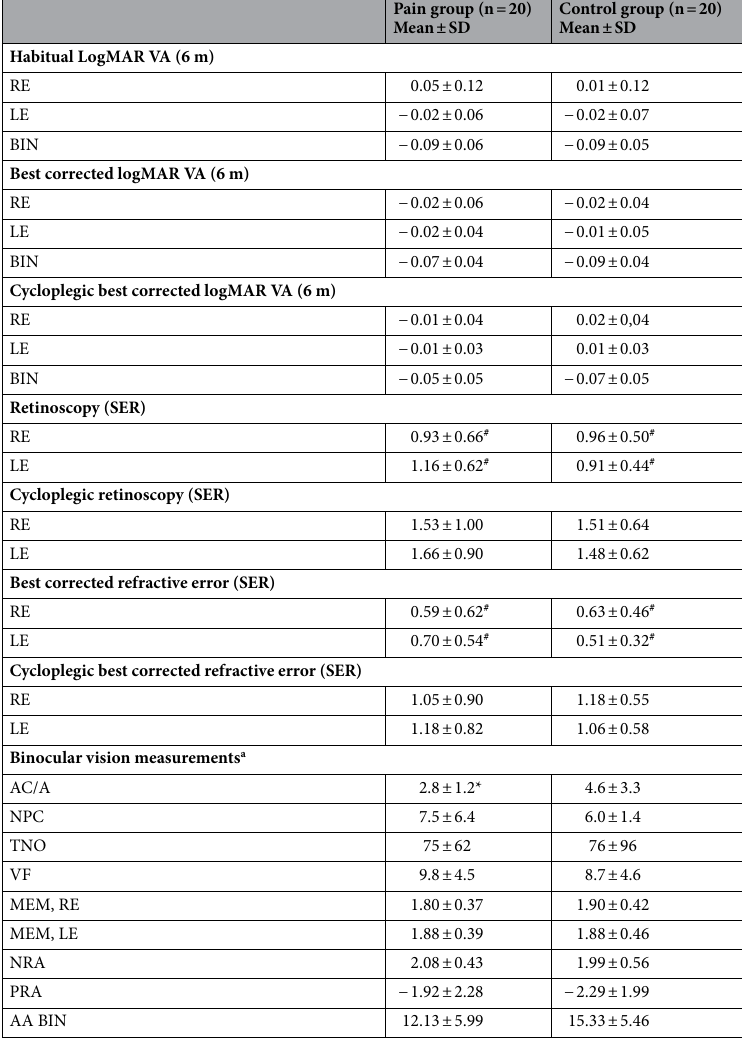
Table 2. Eye examination—average visual acuity, refractive error and binocular status. VA visual acuity, SER spherical equivalent error in diopters (D), RE right eye, LE left eye, BIN binocular (both eyes), AC/A accommodative convergence/accommodation ratio (dp,), NPC near point of convergence (cm), TNO TNO stereopsis (sec arc), VF vergence facility (number of cycles/min), MEM monocular estimate method retinoscopy (D), NRA/PRA negative/positive relative accommodation (D), AA amplitude of accommodation (D). a One child in the pain group was excluded due to esotropia. # Refraction: Statistically significant lower SER within group compared with cycloplegia at p < 0.05. *Statistically significant difference between the groups at p <